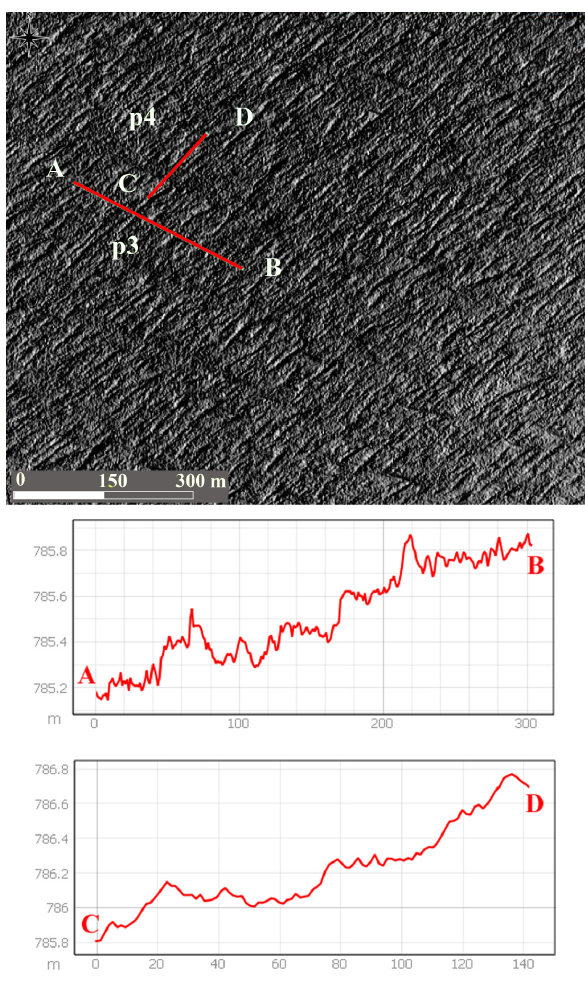
Figure 5. Microtopographic snow/ice features of eolian origin at the site 2: the 1-m gridded hill-shaded map and two cross- sections A–B and C–D. One can see snow/ice microfeatures of eolian origin. For the site location, see Fig. 1